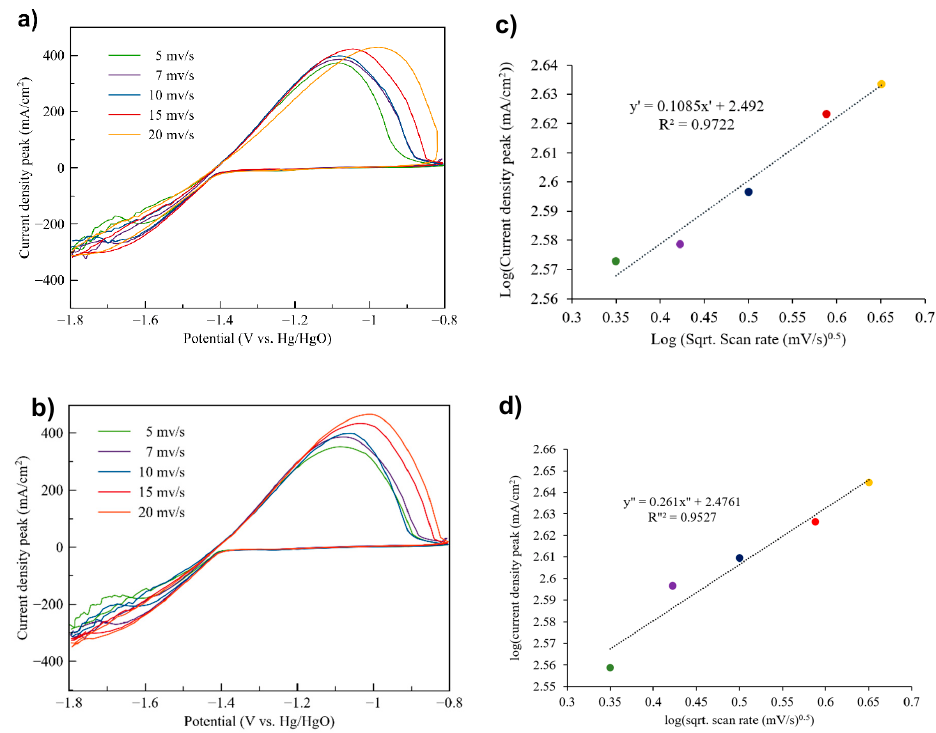
Figure 6. CV curves at different scan rates (5 to 20) mV/s vs. current density for ( a ) Zn/IF and ( b ) Zn/NF electrodes in an electrolyte solution. Logarithmic current density peaks vs. logarithmic square root of scan rate with fitted line for ( c ) Zn/IF and ( d ) Zn/NF. Energies 2020 , 13 , x FOR PEER REVIEW